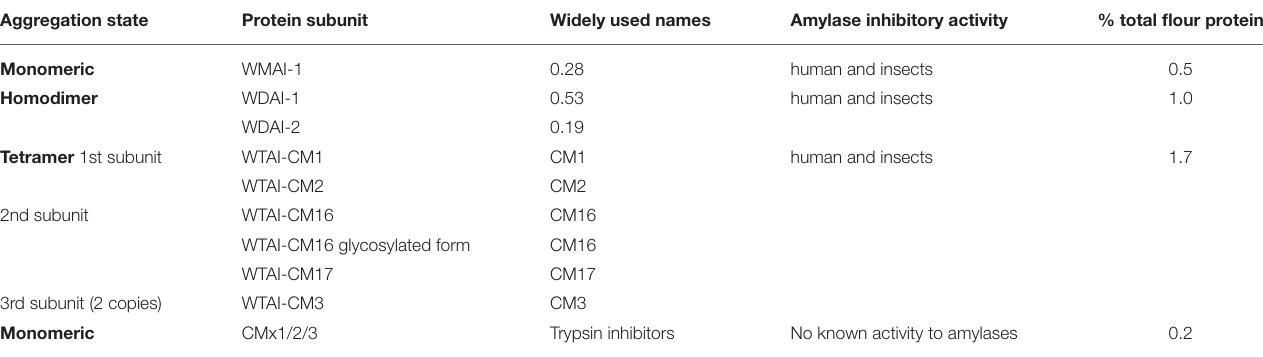
TABLE 1 | Nomenclature, amylase inhibitory activity, and abundance of wheat ATIs. Aggregation